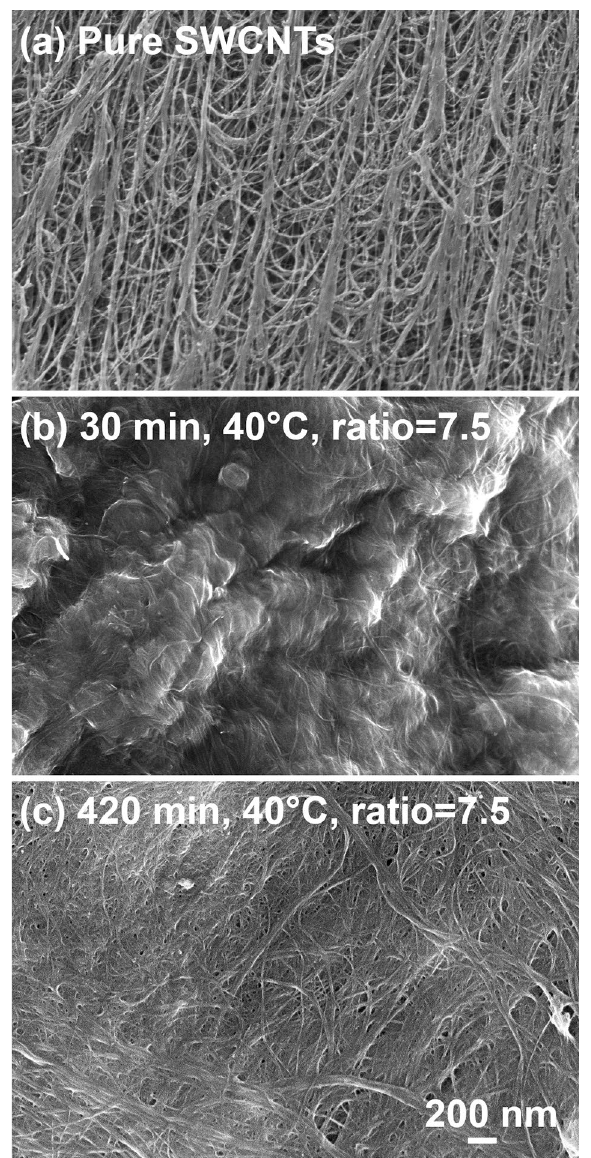
Figure 5. SEM micrographs of pure and oxidized SWCNTs carried out using the specified